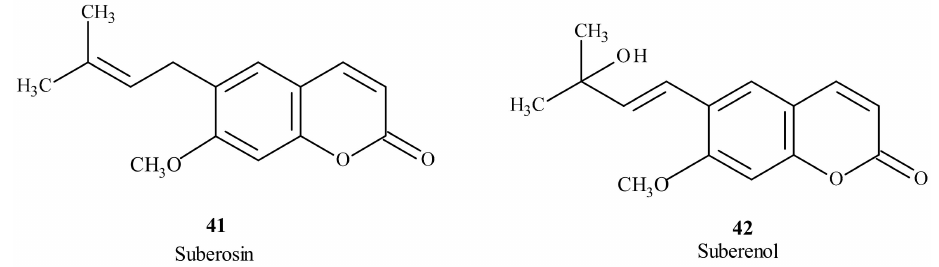
Figure 14. Structures of suberosin ( 41 ) and suberenol ( 42 ).